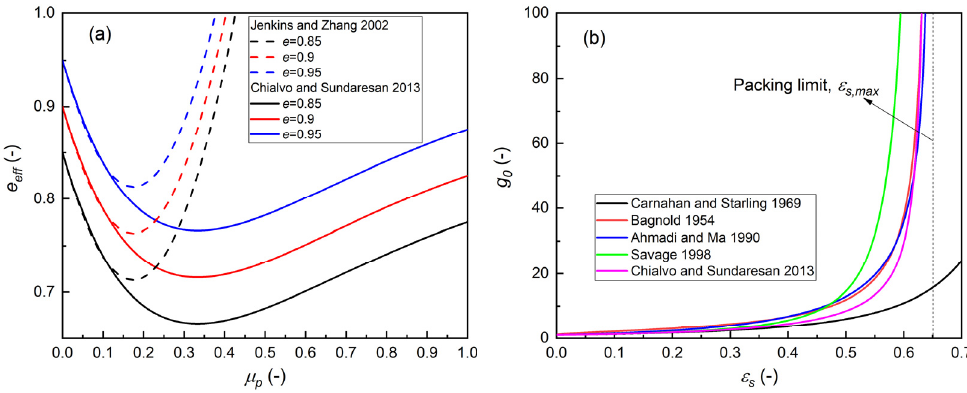
Figure 3. Effective restitution coefficient and radial distribution function, ( a ) Effective restitution coefficient, ( b ) Radial distribution function [28,31,34–37].